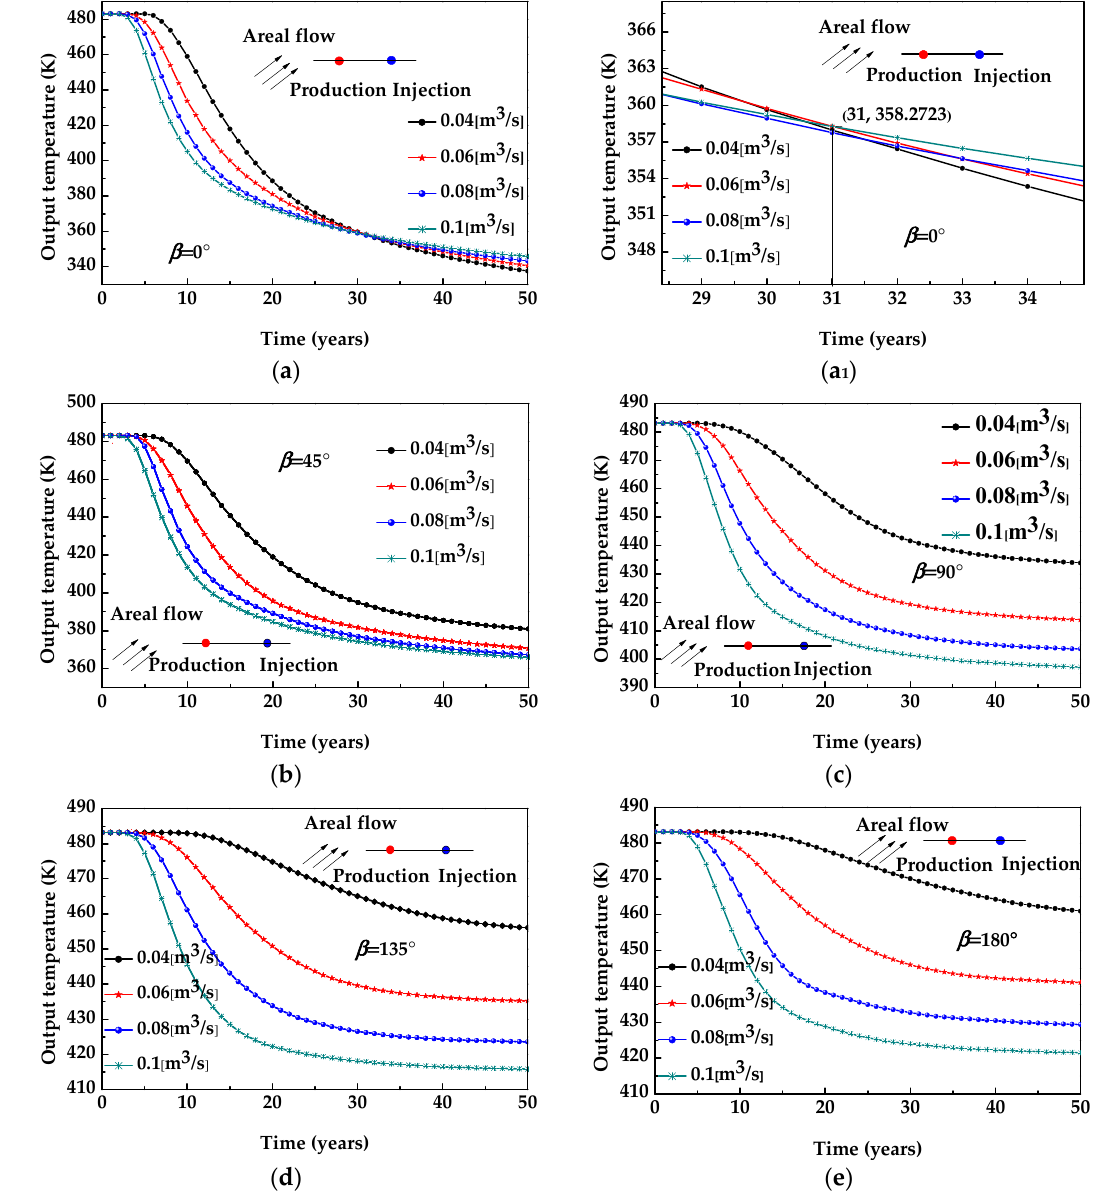
Figure 11. Temperature variation of production wells with time at different flow rate (Where a 1 is the partial details of the graphs a ). ( a ) Evolution of output temperature during 50 years under different flow rate conditions under β = 0°; ( a 1 ) Local amplification of figure a. ( b ) Evolution of output temperature during 50 years under different flow rate conditions under β = 45°; ( c ) Evolution of output temperature during 50 years under different flow rate conditions under β = 90°; ( d ) Evolution of output temperature during 50 years under different flow rate conditions under β = 135°; ( e ) Evolution of output temperature during 50 years under different flow rate conditions under β = 180°.